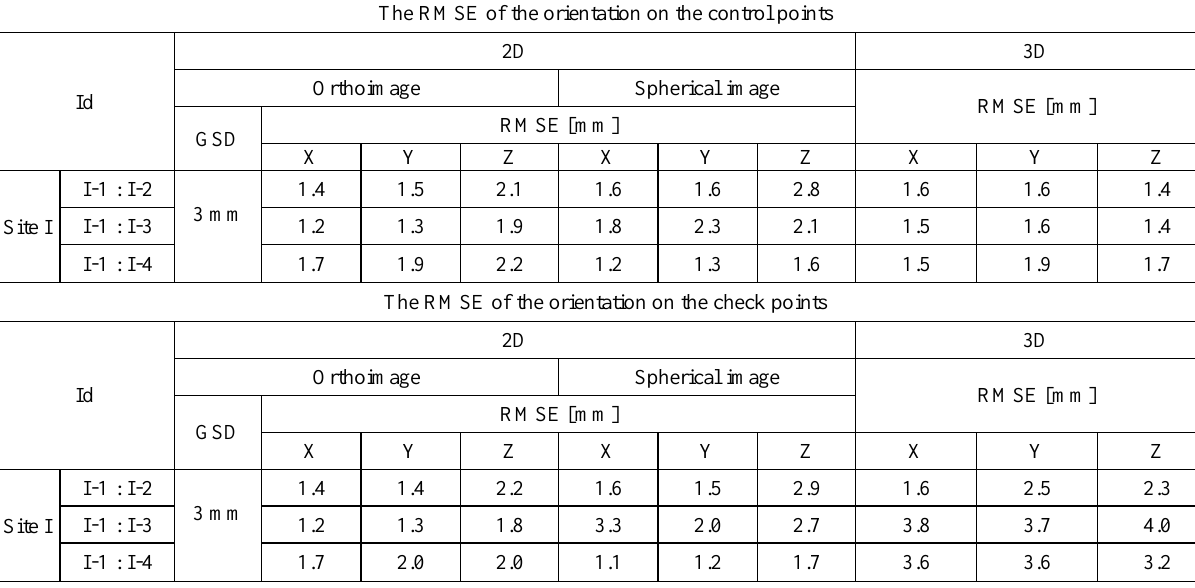
Table 2. RMSE of the point clouds orientation on the control and check points – Test site